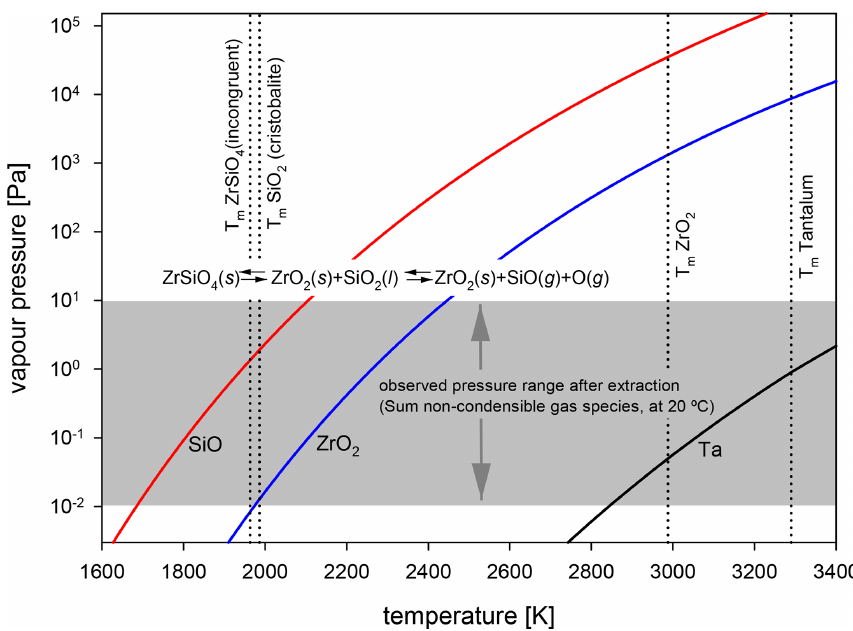
Figure 5. Vapour pressure of Silicon monoxide (SiO), zirconia (ZrO 2 ) and tantalum (Ta) as a function of temperature (Schick, 1960; Hoch et al., 1954; Arblaster, 2018; Kaiser et al., 2008), and the melting points of zircon (ZrSiO 4 ), cristobalite (SiO 2 ) and zirconia (Kaiser et al., 2008). Zircon melts incongruently to ZrO 2 and SiO 2 melt (the melting temperature of the high-temperature modification of SiO 2 , cristobalite, is only ∼ 10K higher than that of zircon) (Kaiser et al., 2008). At a given temperature the vapour pressure of SiO is 1 to 2 orders of magnitude higher than that of ZrO 2 ; the larger differences are at lower temperatures. Above the melting point of cristobalite, SiO can boil off, rather than sublimate from the surface of a solid (as is the case for ZrO 2 , below its melting point), if the pressure in the extraction cell is lower than the vapour pressure. Observations of the residual pressure of non-condensible gases after extraction (at this time the laser furnace is still hot from the extraction, but the laser power is switched off) indicate that in our experimental set-up SiO may boil off at temperatures > 2100K. The higher vapour pressure and the ability to boil off from a liquid lead to a preferential loss of SiO, as compared to ZrO 2 , from zircon at high